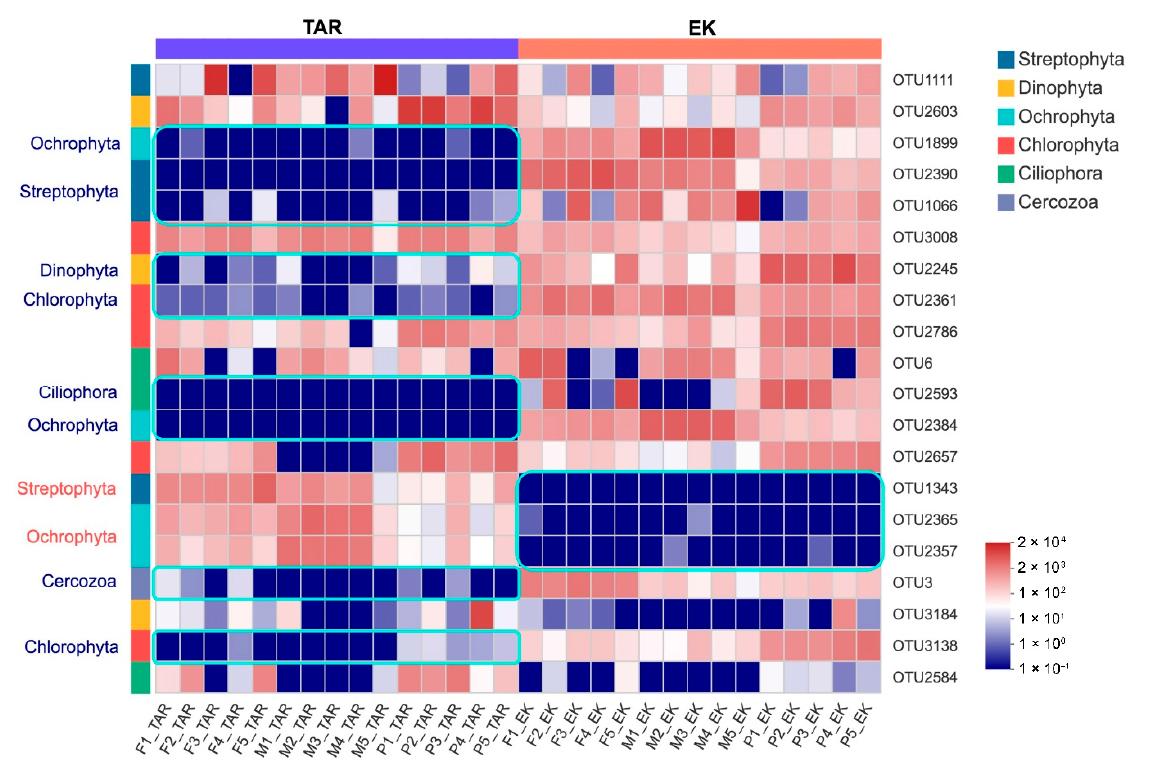
Figure 5. Relative abundances of eukaryotic communities at phylum level detected by two primer sets in samples extracted using the PS, FS, and MG kit.